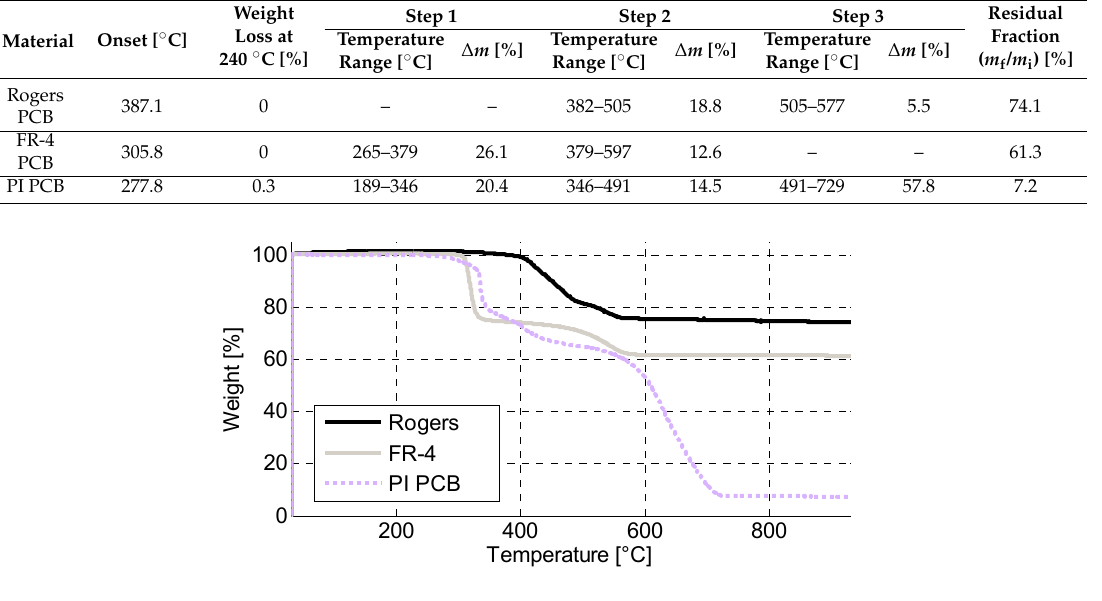
Figure 1. Thermogravimetric analysis results for PCB materials.